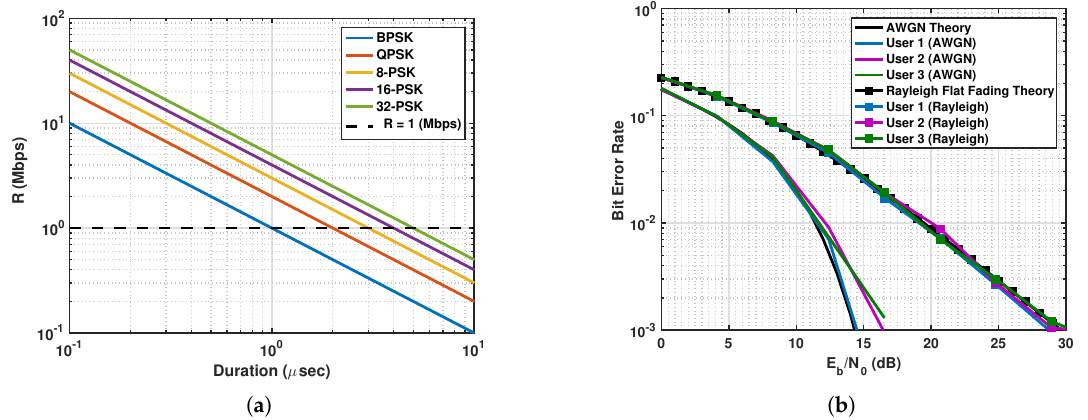
Figure 2. ( a ) Feasible gross bit rate R as a function of symbol duration T c = T for phase shift keying (PSK) modulation orders P =2,4,8,16,32. ( b ) Bit-error rate (BER) performance for varying signal-to-noise ratio (SNR) for three users transmitting over an additive white Gaussian noise (AWGN) channel and a Rayleigh fading channel using the designed OLFM waveform with 16-PSK